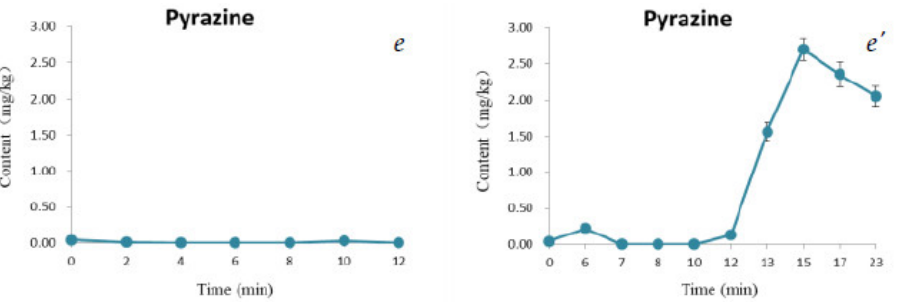
Figure 6. Changes in characteristic volatile compounds of baked beans during microwave-baking ( a – e ) and drum-roasting processes ( a’ – e’ ).